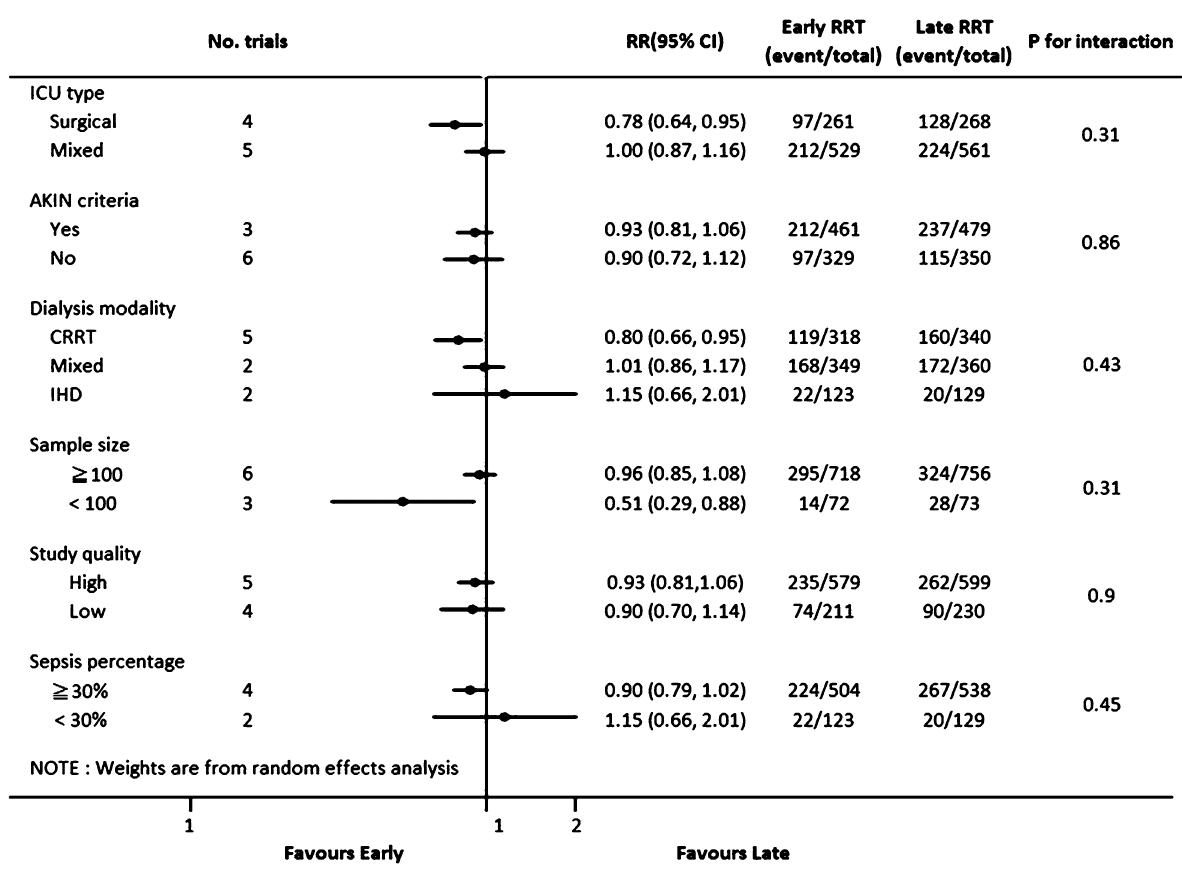
Fig. 4 Forest plot for all‑cause mortality: in subgroups. RCT randomized controlled trials, RRT renal replacement